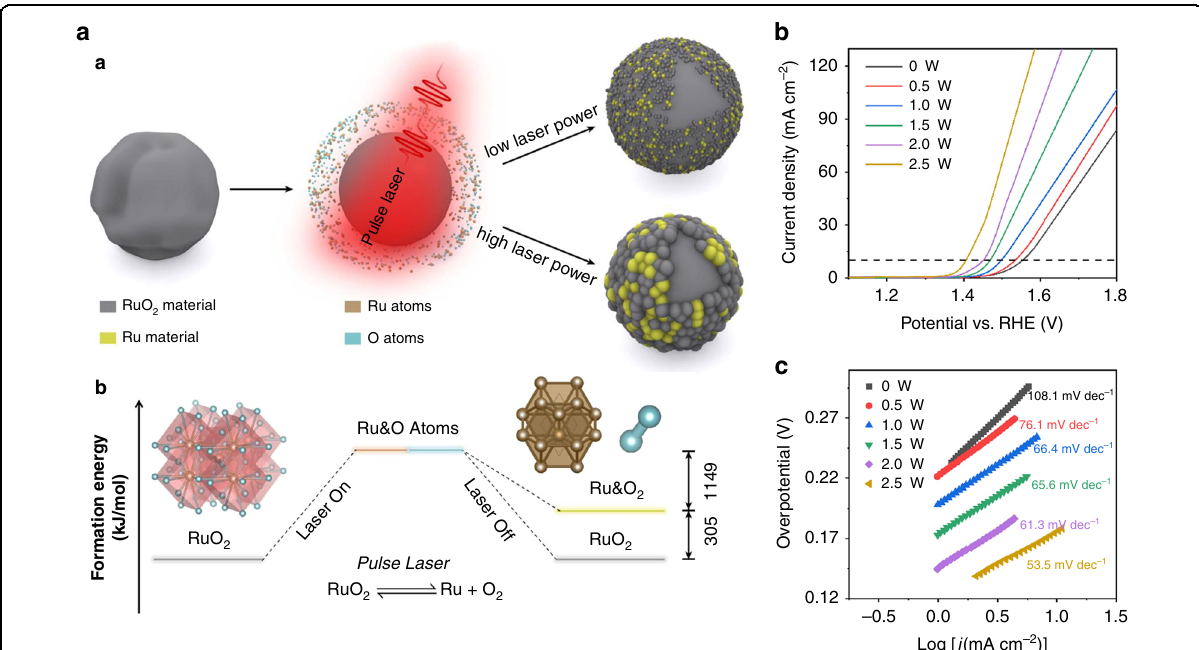
Fig. 18 Ru based electrocatalysts productivity as a function of laser power. a( a, b) Schematic of Ru/RuO 2 on RuO 2 nanoparticle preparation using PLA, b LSV for OER, and c Tafel graph for OER 213 . Copyright (2021)